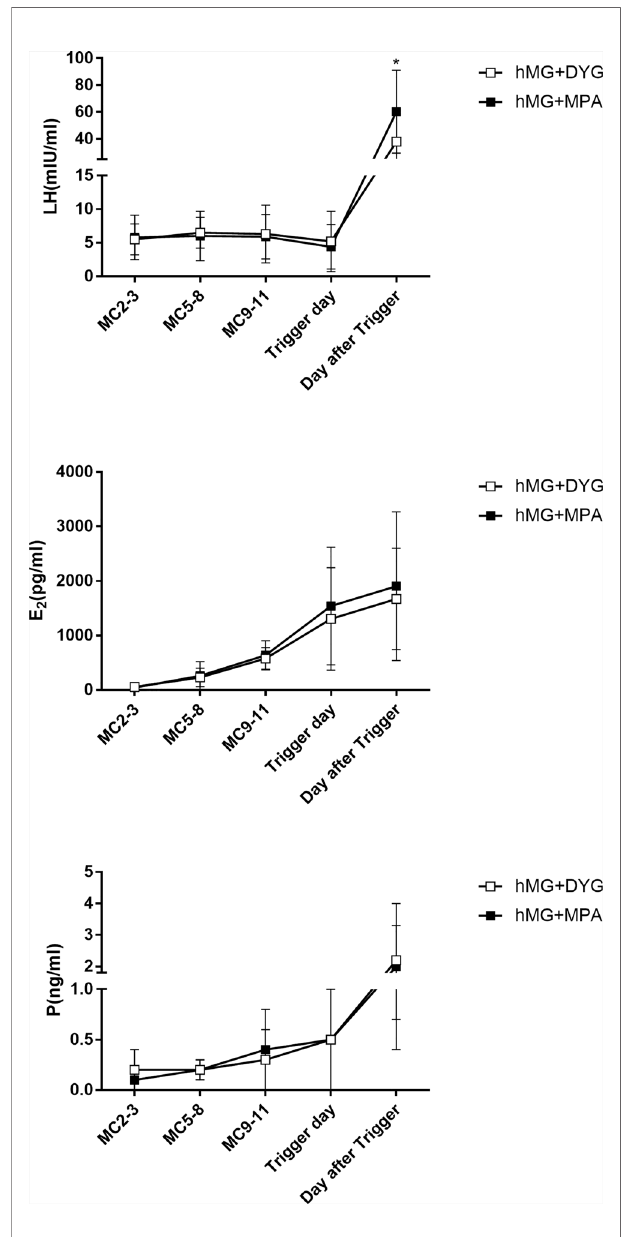
FIGURE 1 | Serum hormone pro fi les of the hMG+DYG and hMG+MPA protocols. The asterisk indicates signi fi cant changes in the values at different time points between the two groups (*P < 0.001).LH,luteinizing hormone; E2, estrogen; P,